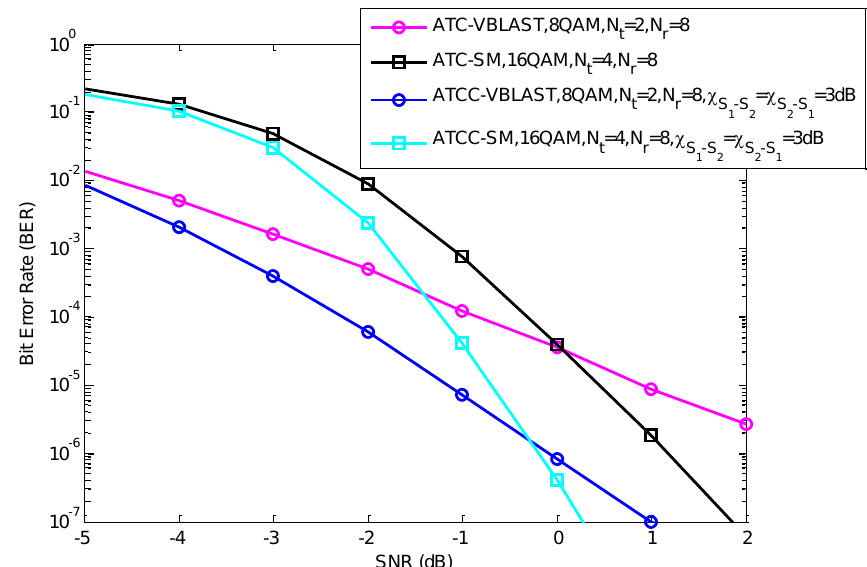
Figure 16. BER performance comparison of ATC-SM over 16QAM, two-source ATCC-SM over 16QAM under a non-ideal inter-user channel scenario, ATC-VBLAST over 8QAM, and two-source ATCC-VBLAST over 8QAM under a non-ideal inter-user channel scenario over the slow Rayleigh fading channel for the case of 6b/s/Hz transmission, K = 2048 and N r = 8 .